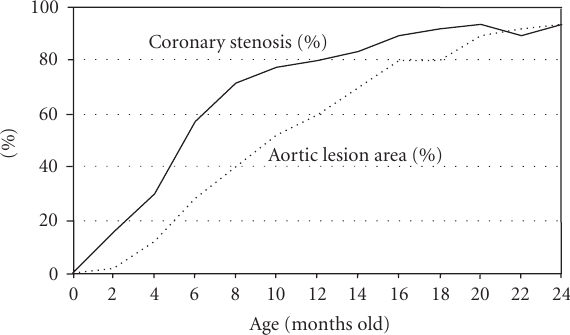
Figure 2: Development of atherosclerotic lesions in WHHLMI rabbits with age. The solid line denotes the degree of coronary atherosclerosis shown as coronary cross-sectional narrowing; lesion areas/area surrounded by the internal elastic lamina × 100 (%). The dotted line denotes the degree of aortic atherosclerosis; sum of the surface areas of the lesion/total surface area of the aortic lumen × 100 (%). Modified from Shiomi and Ito